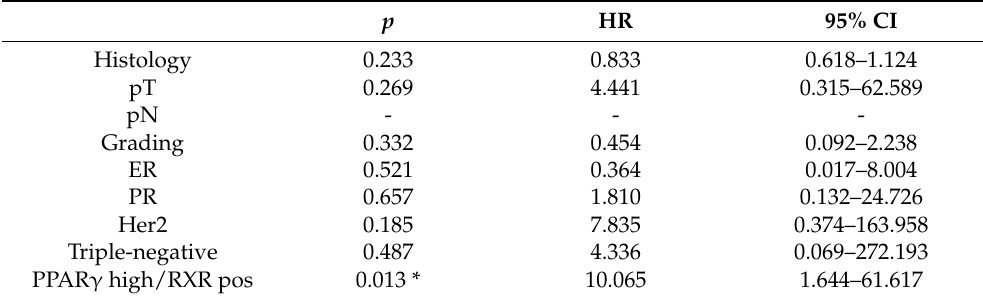
Table 5. Cox multivariate analysis for positive RXR α /high expression PPAR γ high expression in the stage 1A